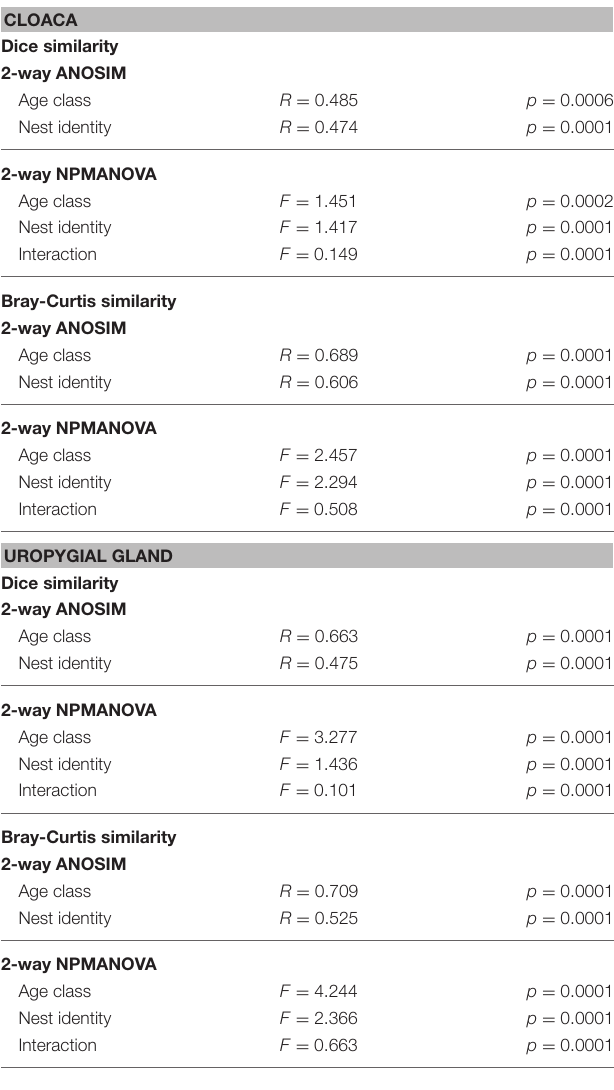
TABLE 1 | Analyses evaluating variation in the composition (Dice similarity) and structure (Bray-Curtis similarity) of cloacal and uropygial gland microbiota based on age class and nest